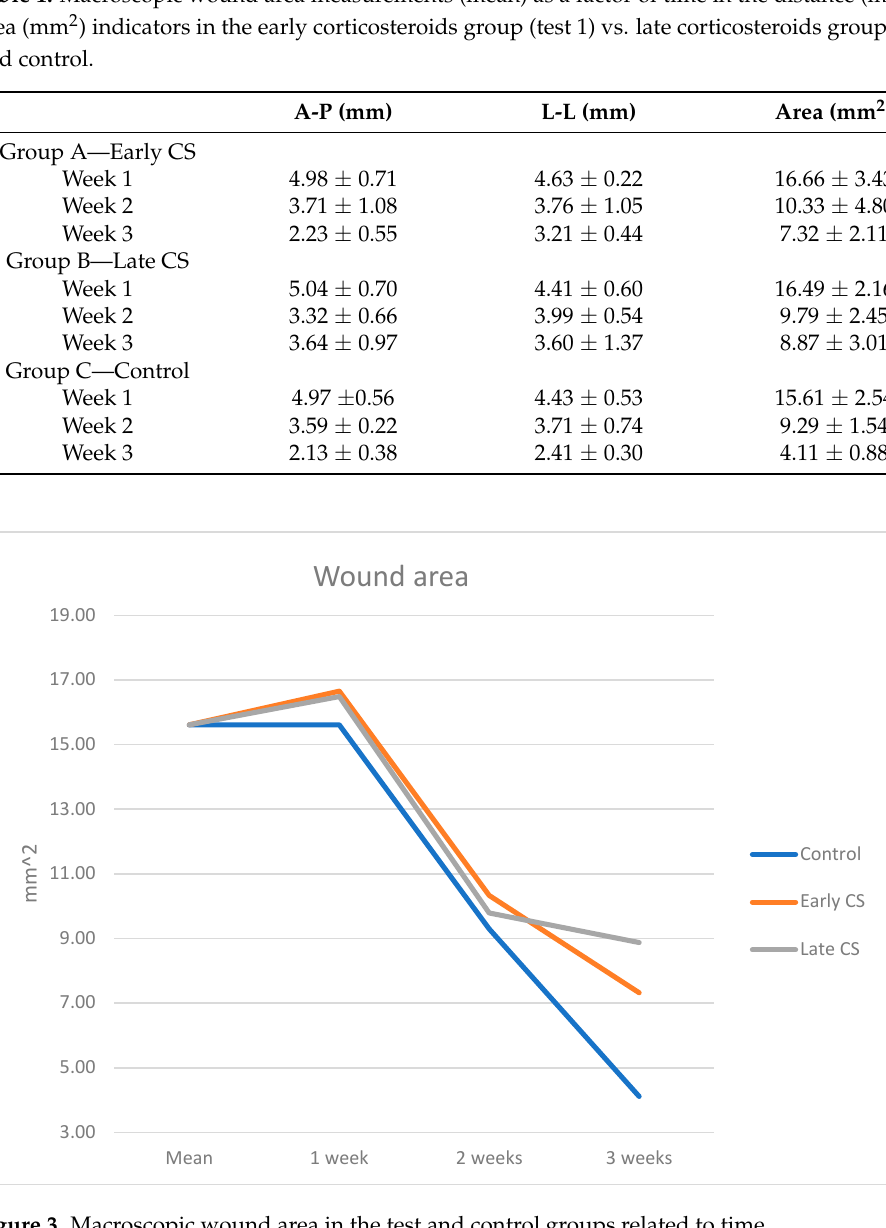
Figure 3. Macroscopic wound area in the test and control groups related to time. Two weeks: Total wound area in the Early CS group was 10.33 ± 4.80 mm 2 , Late CS group 9.79 ± 2.45 mm 2 , and 9.29 ± 1.54 mm 2 in the control group ( p = 0.903). Three weeks: Total wound area in the Early CS group was 7.32 ± 2.11 mm 2 , Late CS group 8.87 ± 3.01 mm 2 , and 4.11 ± 0.88 mm 2 in the control group ( p = 0.075) with no